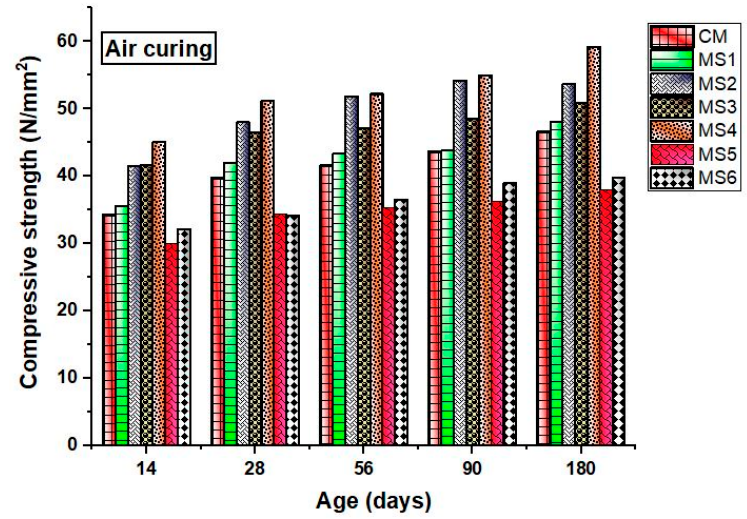
Figure 4. Compressive strength of the concrete mixes in air curing at various ages.